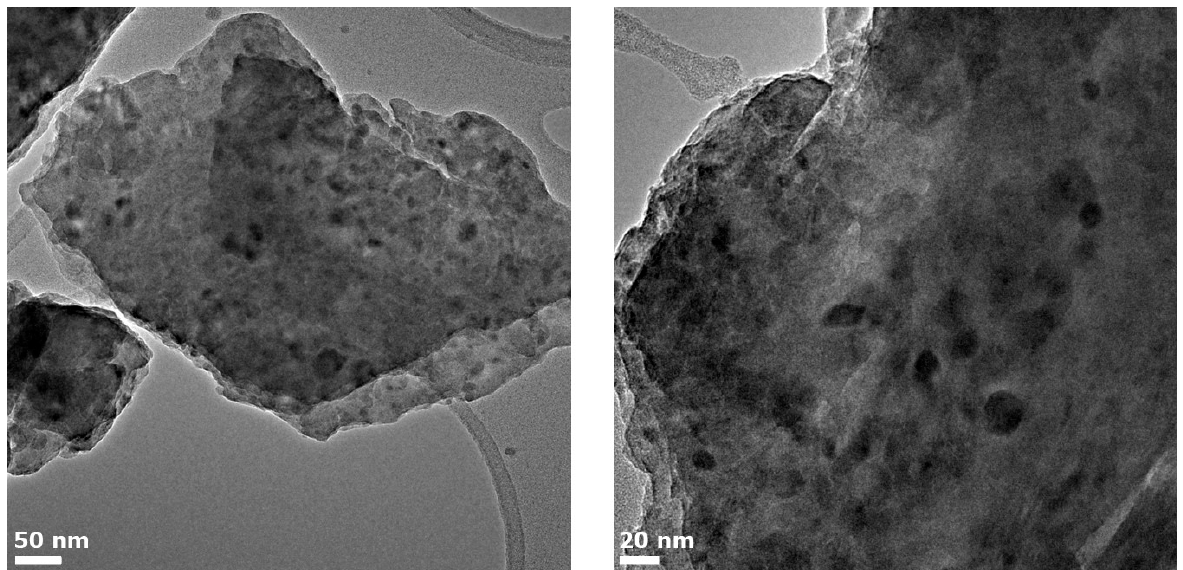
Figure 6. TEM images of zone